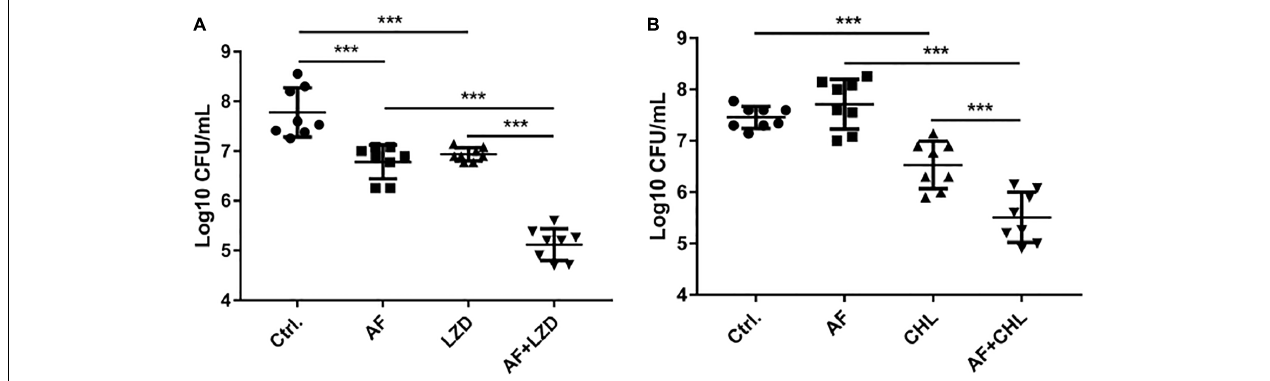
FIGURE 3 | Antibiofilm activity of AF alone/in combination with antibiotics on preformed isolated biofilms on catheters. Biofilms on the surfaces of catheters were treated with AF, LZD, or CHL as described in Section “Materials and Methods.” Viable cells remaining on the catheter surface were counted by serial dilution